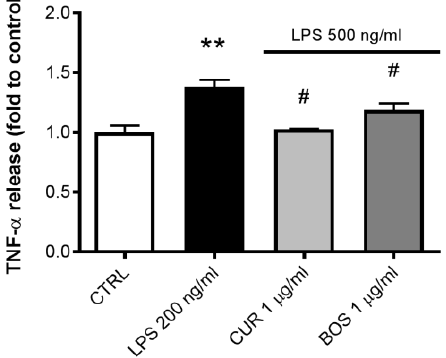
Figure 4. TNF- α release in Caco-2 after 24 h of LPS stimulation (500 ng/mL); cells were preincubated with CUR and BOS for 24 h. ** p < 0.01 vs. control; # p < 0.05 vs. stimulus.